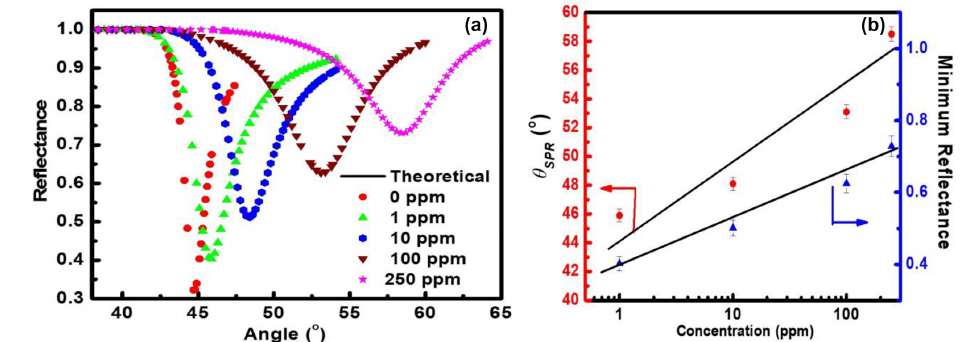
Figure 3. (a) Variation of reflectance with incident angle (i.e., SPR reflectance curve) for the prism / Au / ZnO structure on interaction with NO 2 gas of fixed concentrations varying from 1 to 250ppm and (b) linear change in SPR angle ( θ SPR ) and minimum reflectance with varying concentration of NO 2 gas (calibration curve).